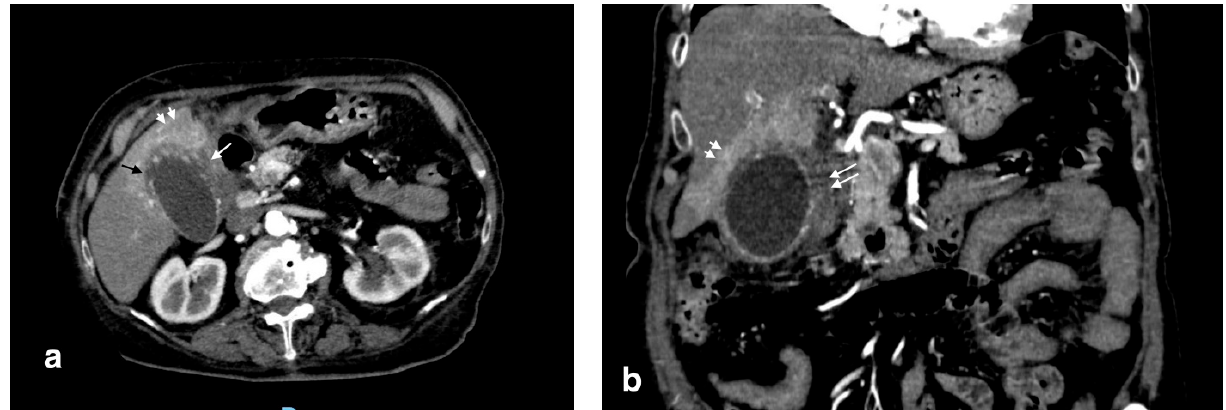
Figure 2. Gangrenous cholecystitis: irregular wall thickening with bulging and focal defects in the gallbladder wall (black arrows, ( a )). Coexisting hepatic hyperemia (arrowheads) and pericholecystic fluid (white arrows) ( a , b ).